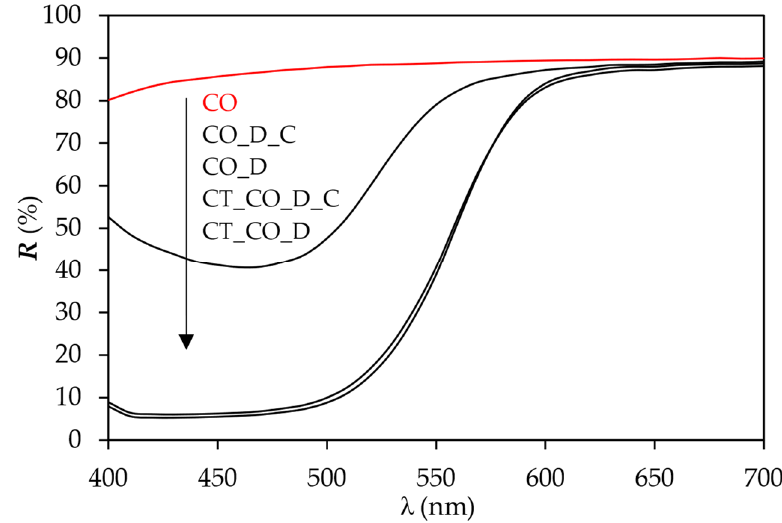
Figure 4. Reflection curves of samples CO, CO_D, CO_D_C, CT_CO_D and CT_CO_D_C.